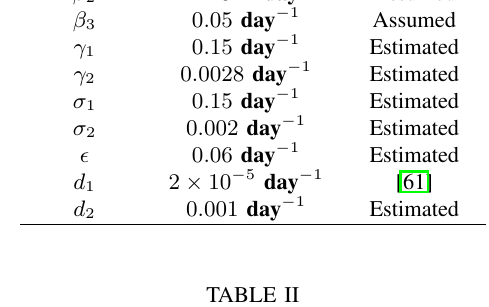
P RELIMINARY POPULATION DENSITY FOR C OVID